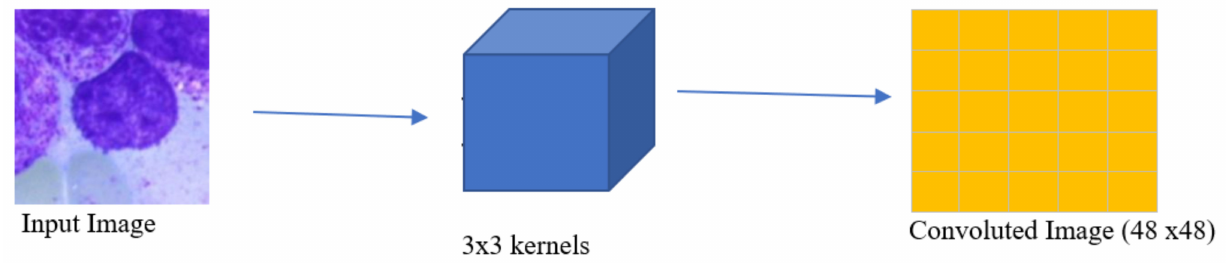
Figure 4. Outline of operation principle of convolution layer with 3 × 3 kernel.